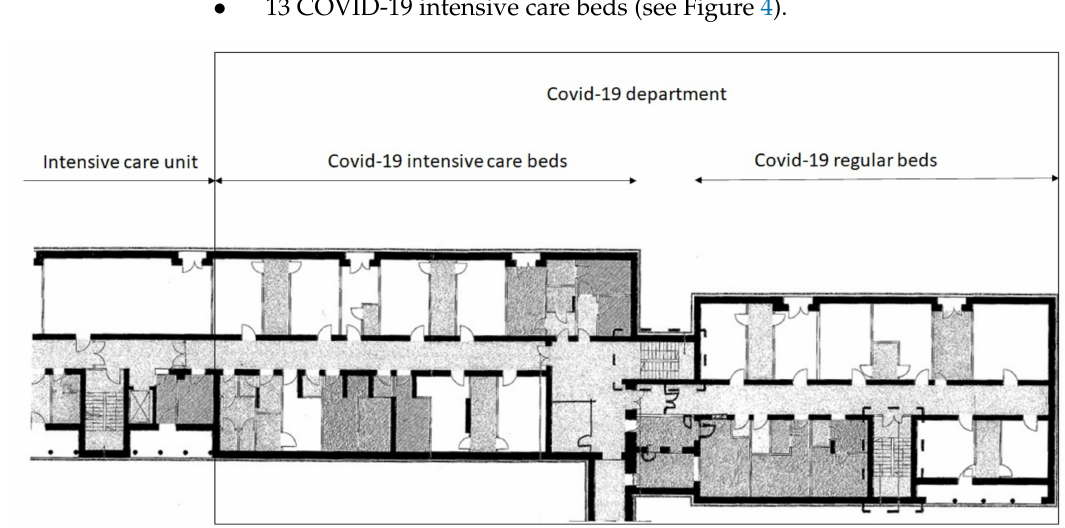
Figure 4. Architectural floor in the hospital source: Hospital internal